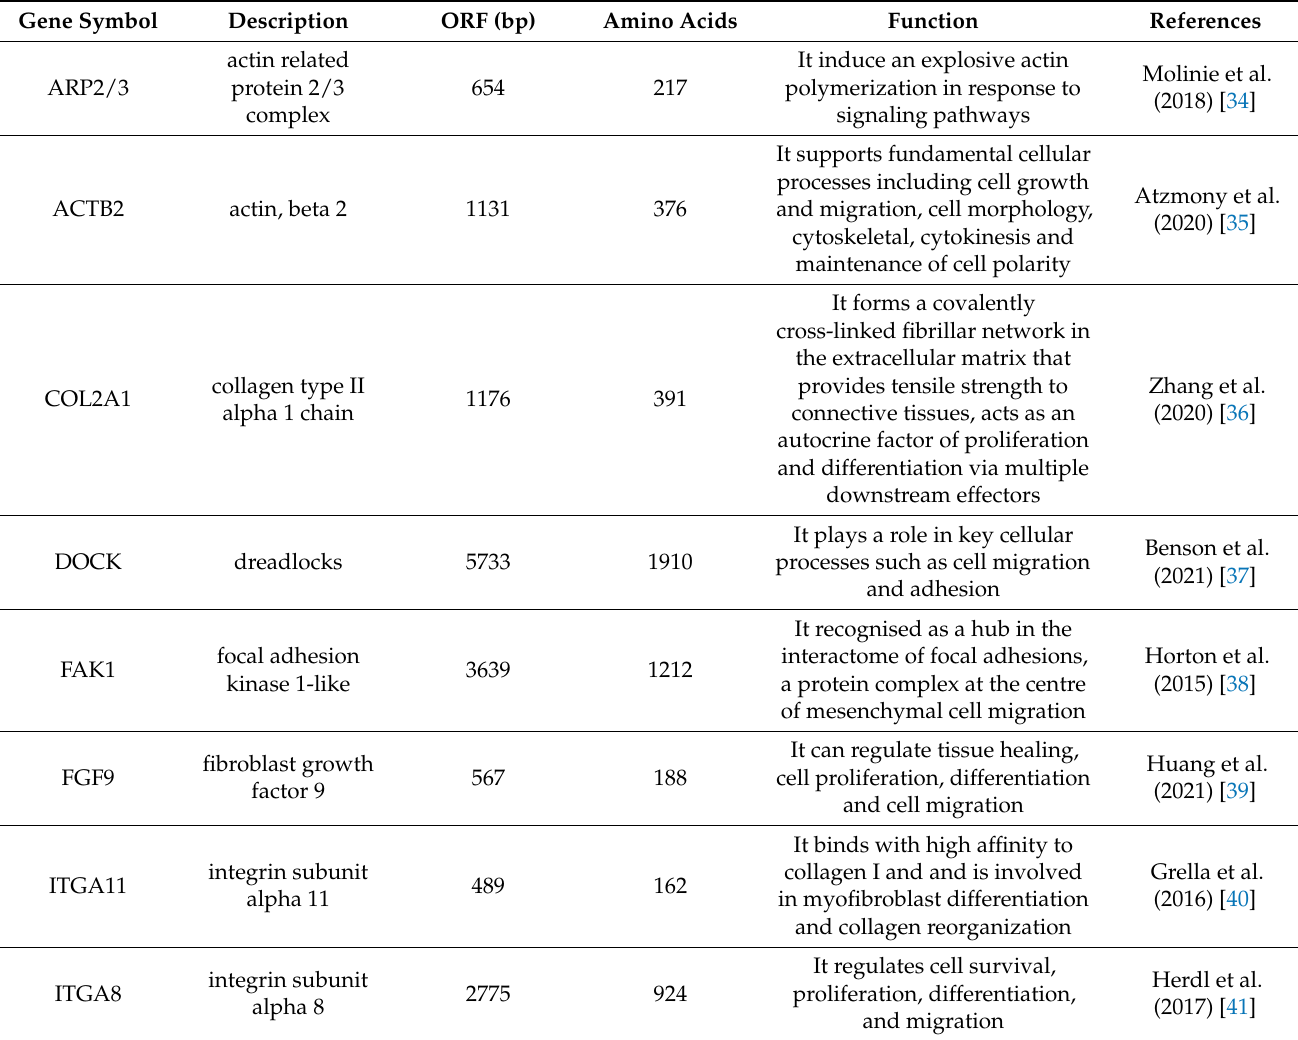
Table 1. Identification of the molecule relative to wound healing in